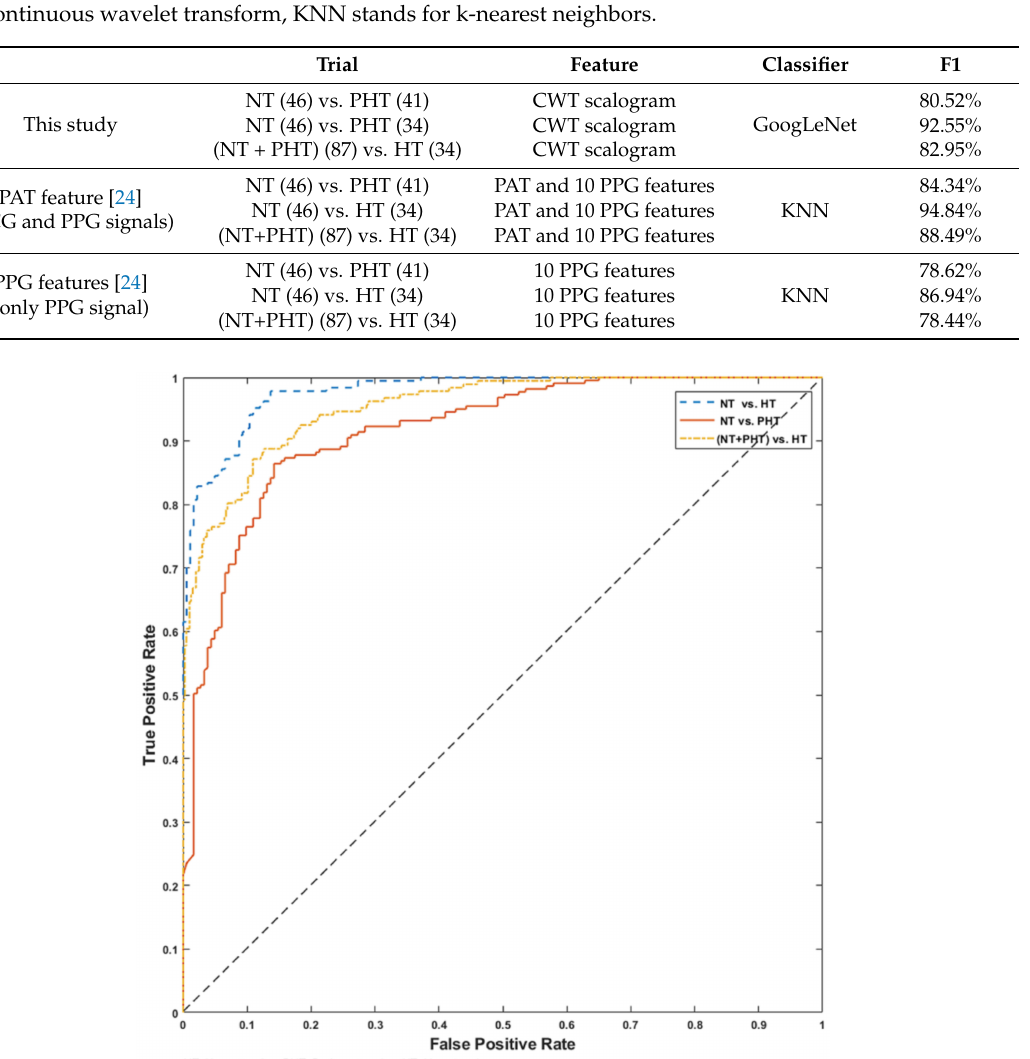
Figure 4. The receiver operating characteristic (ROC) curve of the three classification